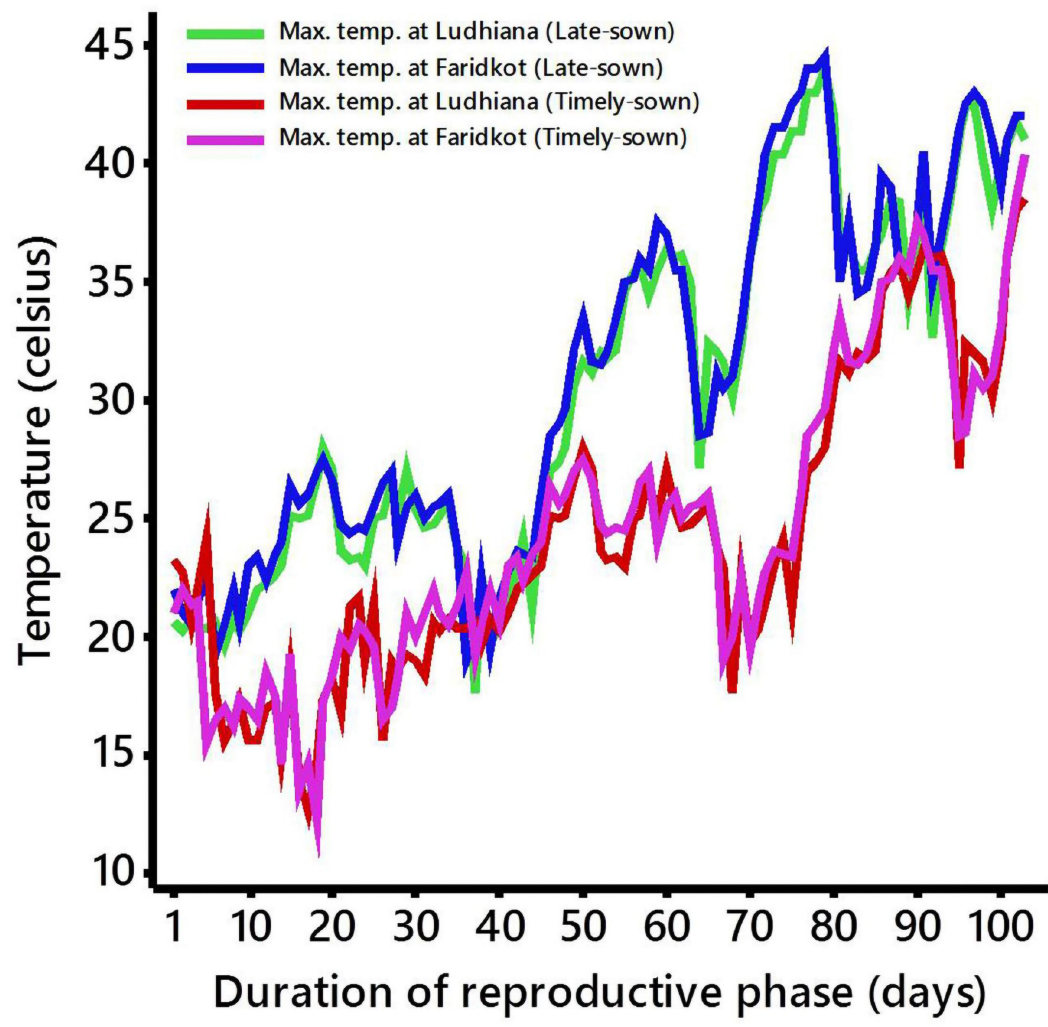
Fig 1. Daily maximum temperatures for late-sown as well as timely-sown conditions during the reproductive phase at both locations (Ludhiana and